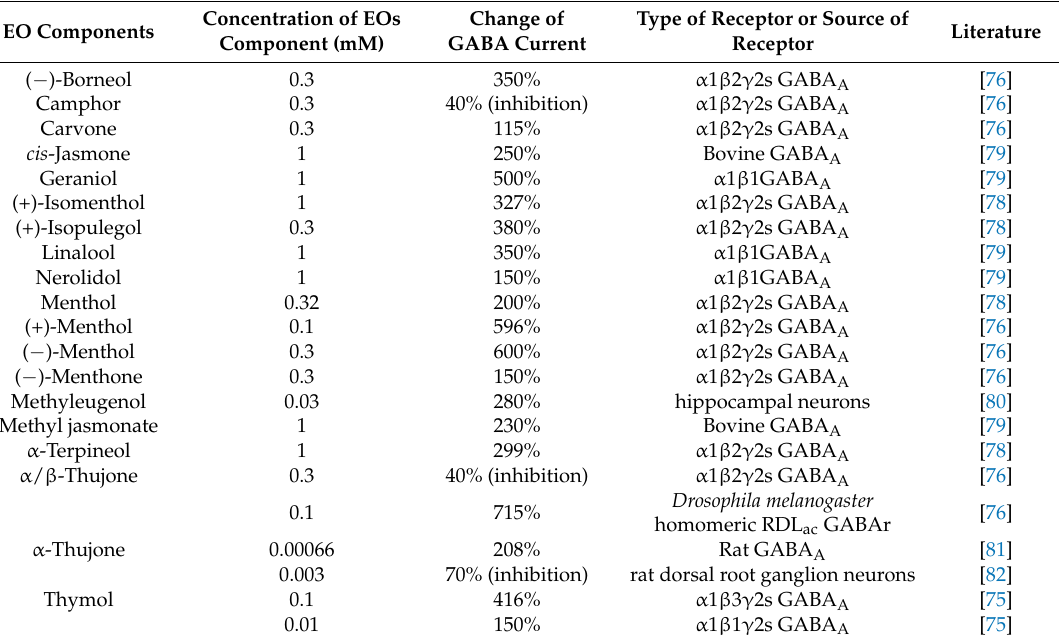
Table 3. The intensification of the GABA-induced Cl − current by